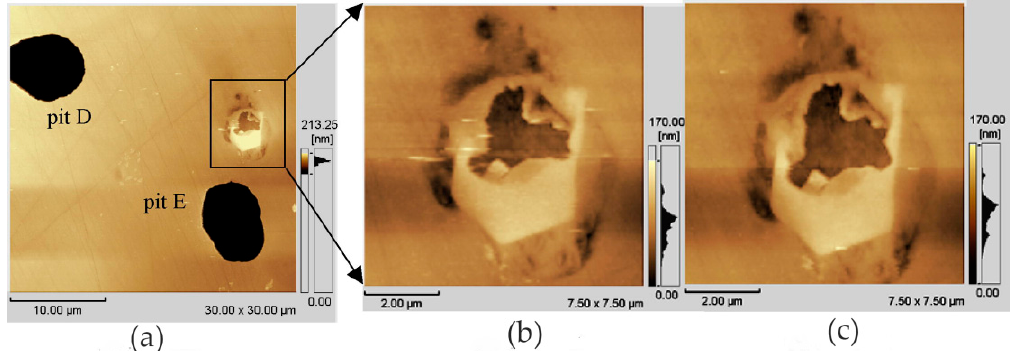
Figure 13. AFM images of solution-treated SUS304 stainless steel after corrosion in sodium chloride solution at 298 K (I = 5 A/m 2 ): ( a ) t = 1.5 ks; ( b ) t = 1.5 ks and ( c ) t = 7.2 ks are the magnified images of the framed area of ( a ), showing the presence of the corrosion product. Reprinted with permission from Reference [48]; copyright 2005 Elsevier Ltd.